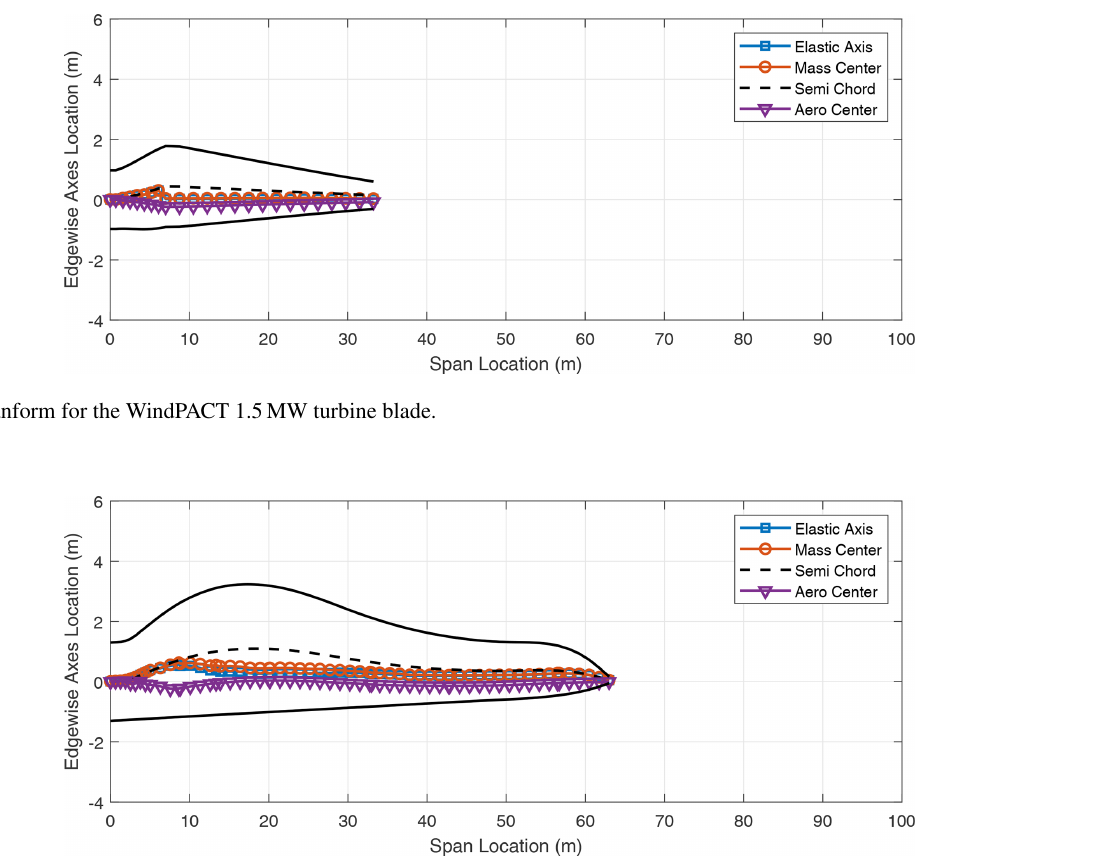
Figure A2. Planform for the IEA 3.4MW turbine blade.